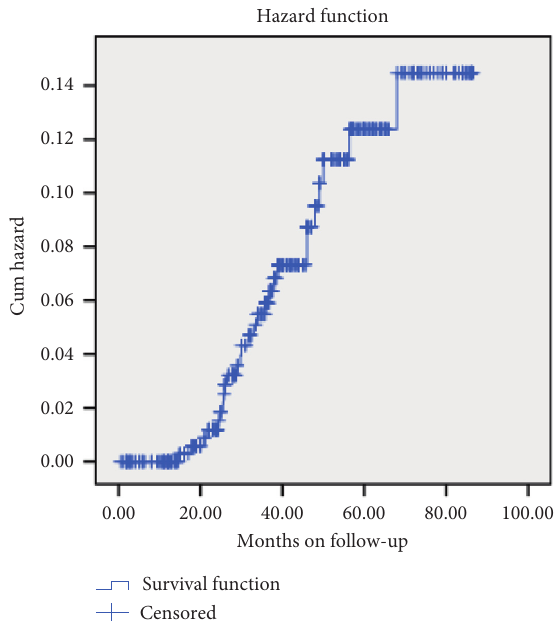
Figure 1: Cumulative probability of first-line ART failure among patients in Shashamene town health